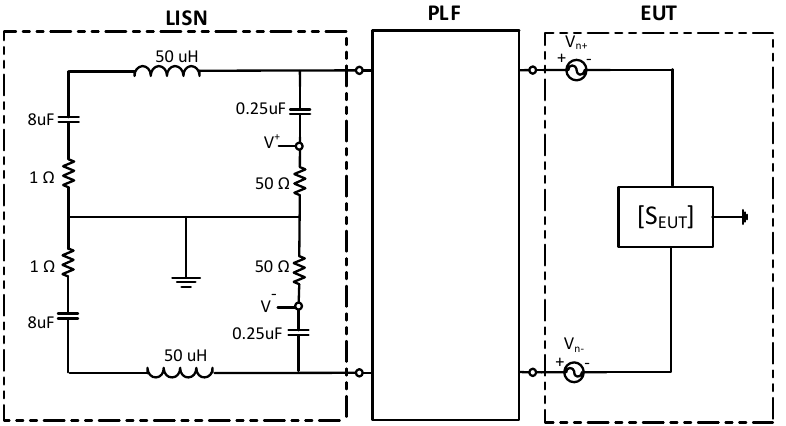
Figure 6. PLF connected between the equivalent circuit of a EUT and the equivalent circuit of a LISN according to CISPR 16.